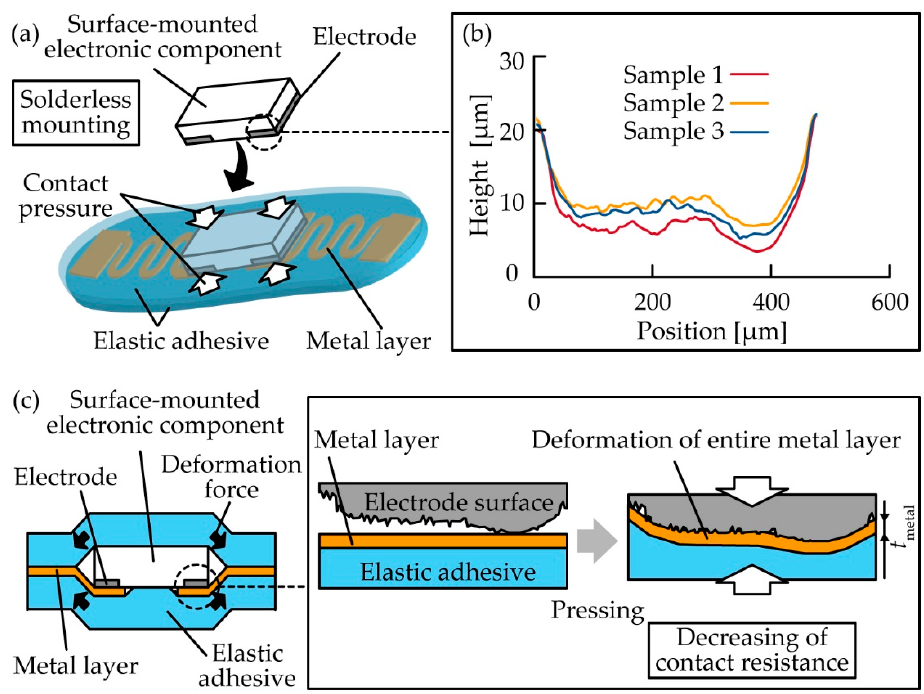
Figure 1. ( a ) Schematic image of electronic component mounting through contact pressure using an elastic adhesive; ( b ) electrode surface profiles of surface-mounted electronic component; ( c ) deformation of contact pad of metal layer of elastic adhesive sheet by gradually increasing contact pressure.